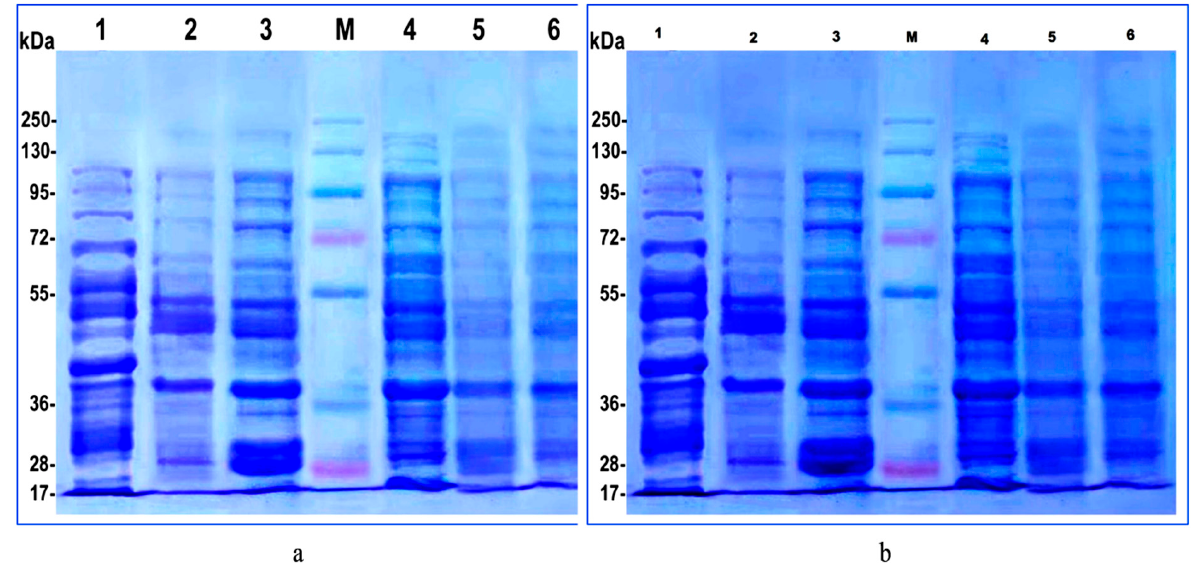
Figure 1. Electrograph SDS-PAGE of glutenin protein extracted from grains of two wheat cultivars treated with silicon and nanosilicon ( a ) cv. Shandaweel 1 and ( b ) cv. Gemmeiza 9: M, protein marker; Lane 1, control; Lane 2, 1.5 mM potassium silicate; Lane 3, 1.66 mM nanosilicon; Lane 4, heated